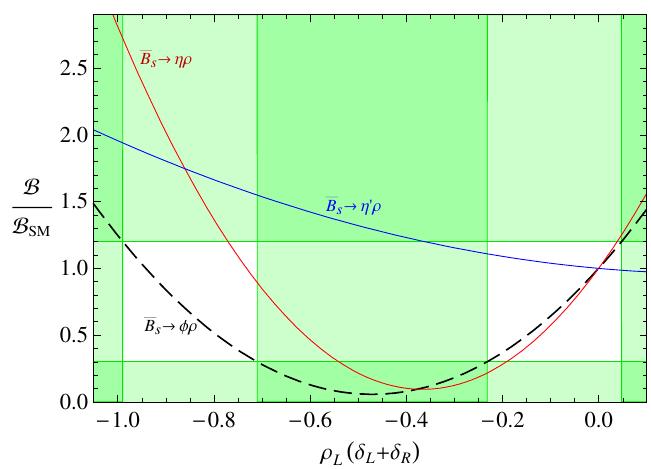
Figure 3 . The calculated branching fractions of (cid:22) B s ! (cid:17)(cid:26) 0 (red solid curve), (cid:22) B s ! (cid:17) 0 (cid:26) 0 (blue solid curve), and (cid:22) B s ! (cid:30)(cid:26) 0 (black curve), normalized by their respective SM predictions listed in table 2, versus the product (cid:26) ( (cid:14) L + (cid:14) R ) in the case where (cid:26) = 0 : 1 (cid:26) and m = 1 TeV. The vertical length L R L Z 0 of the unshaded areas and the (cid:26) ( (cid:14) L + (cid:14) R ) values within them satisfy the restriction in eq. (3.11). L up to (cid:24) 2 : 7 times its SM value, whereas for (cid:22) B ! (cid:17) 0 (cid:26) 0 (blue solid curve) the enhancement s is at most about 1.9 times.